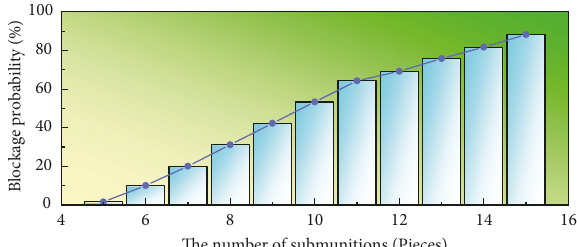
Figure 11: Comparison of simulation results.